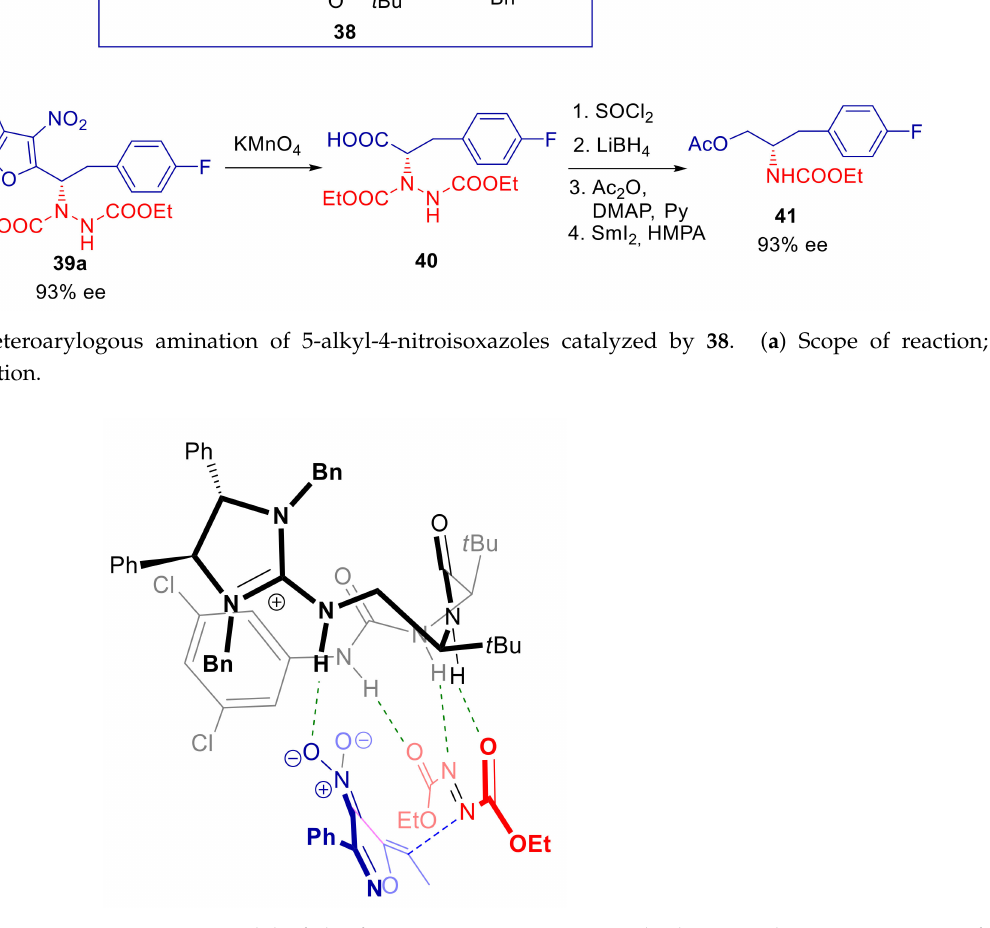
Figure 3. Model of the favorite transition state in the heteroarylogous amination of 5-alkyl-4- nitroisoxazoles catalyzed by 38 , resulting from DFT calculations and NCI analysis. Green spotted lines represent hydrogen bonds, blue spotted line represents forming C-N